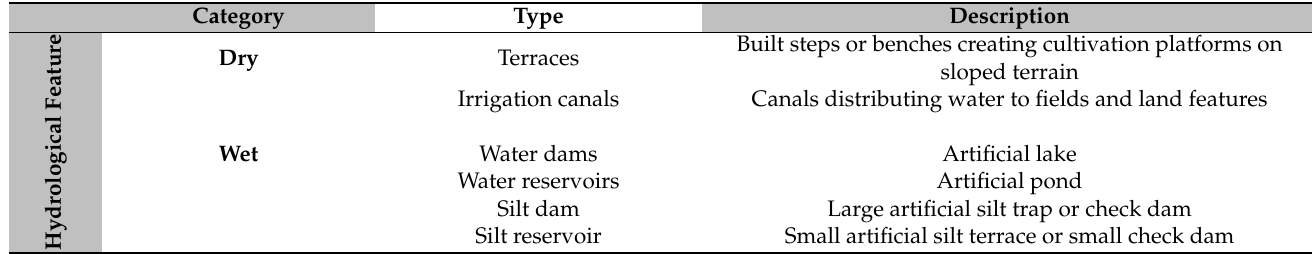
Table 1. Types and categories of hydrological features referred to here.